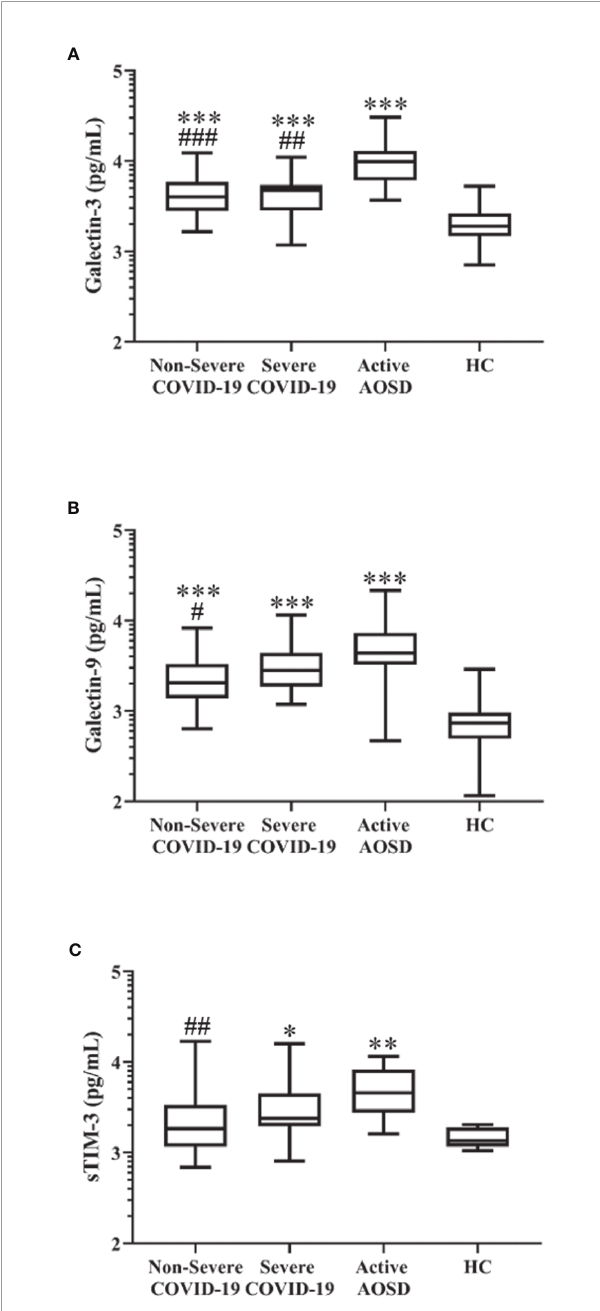
FIGURE 1 | Comparison of plasma levels of Gal-3, Gal-9, and sTIM-3 in COVID-19, AOSD and HC. The difference in levels of Gal-3 (A) , Gal-9 (B) , and sTIM-3 (C) among non-severe COVID-19, severe COVID-19, active AOSD, and healthy control (HC). COVID-19, coronavirus disease 2019; AOSD, adult-onset Still ’ s disease; Gal-3, galectin-3; Gal-9, galectin-9; sTIM-3, soluble cell immunoglobulin and mucin-containing-molecule-3. Data are presented as logarithmic scale and box-plot diagrams, with the box encompassing the 25 th percentile (lower bar) to the 75 th percentile (upper bar). The horizontal line within the box indicates median value respectively for each group. *p-value < 0.05, **p-value < 0.01, ***p-value < 0.001, versus